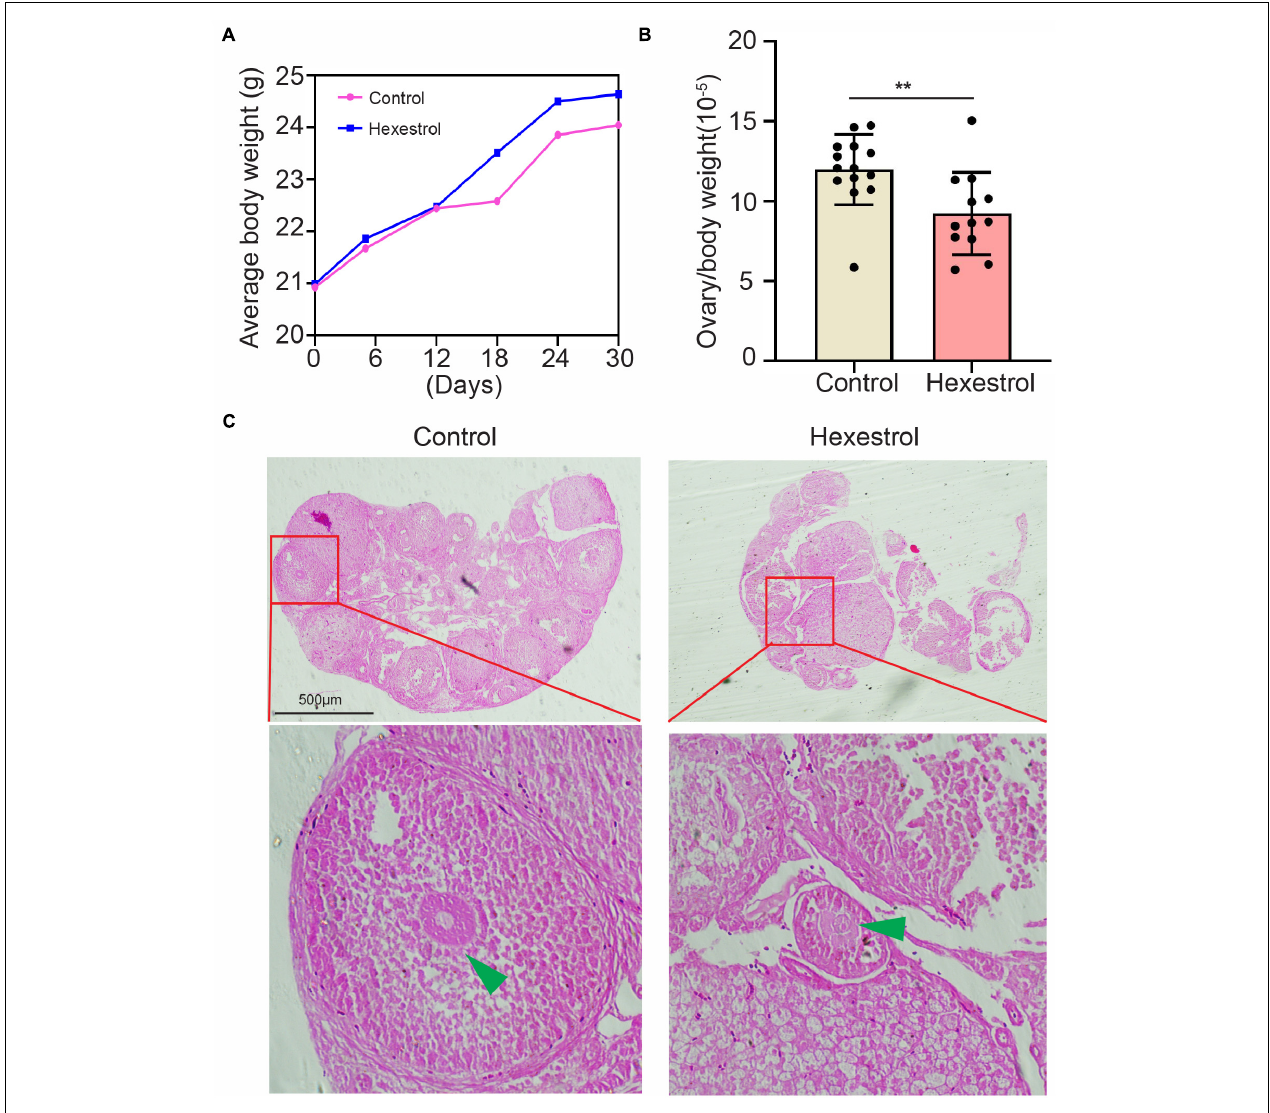
FIGURE 1 | HES affects mouse ovary weight and morphology. (A) Compared with control group, body weight was slightly though not significantly increased. (B) Ovary weight was significantly reduced after exposure to HES. ** P = 0.0074. Data are represented as mean ± SD from at least three independent experiments. (C) Representative H&E histochemical section images of ovaries from control and HES-exposed groups. Scale bar, 500 µ m.